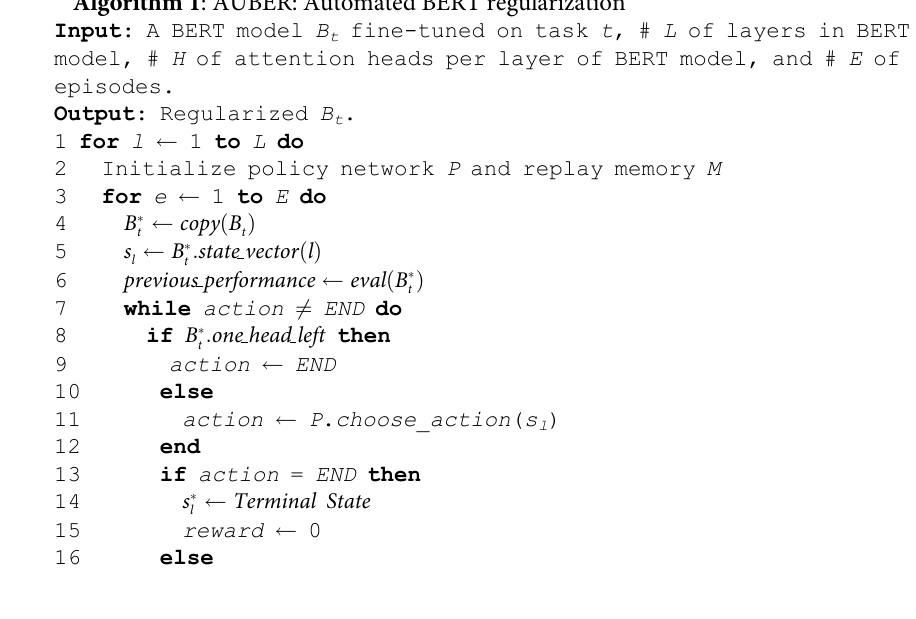
Algorithm 1 : AUBER: Automated BERT